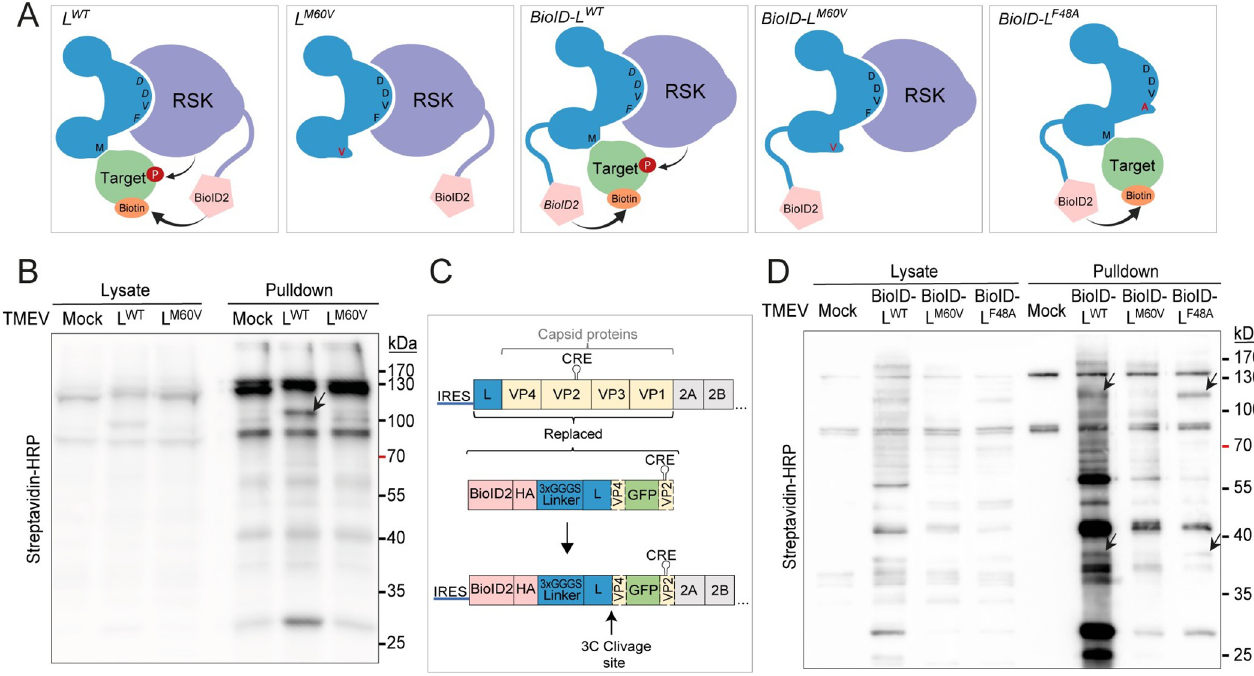
Fig 5. BioID-RSK and BioID-L fusion proteins biotinylate specific proteins during cardiovirus infection. (A) Cartoon showing the expected biotinylation by BioID-RSK or BioID-L fusion proteins of a target recruited by the C-terminal domain of L. (B) Western blot of proteins biotinylated by BioID-RSK in lysates and pulled down samples of TMEV-infected cells. HeLa BioID-RSK cells were incubated for 2 days without biotin. Cells were then infected for 16h (MOI 2.5) with L WT or L M60V viruses in medium containing 5 μ M biotin. Biotinylated proteins were pulled-down using streptavidin-magnetic beads. (C) Schematic representation of BioID-L TMEV replicon constructs. Capsid protein sequences were replaced by BioID-L and GFP sequences. The beginning of the VP4 sequence was kept in order to allow BioID-L protein processing by viral protease 3C, and the CRE sequence (localized in VP2) was re-introduced after GFP in the construct to allow replication. (D) Western blot of proteins biotinylated by BioID-L in lysates and pulled down samples of TMEV infected cells. HeLa cells were infected for 14h (MOI 2.5) with BioID-L WT , BioID-L M60V or BioID-L F48A replicons in medium containing 5 μ M biotin. Biotinylated proteins were then pulled-down using streptavidin-magnetic